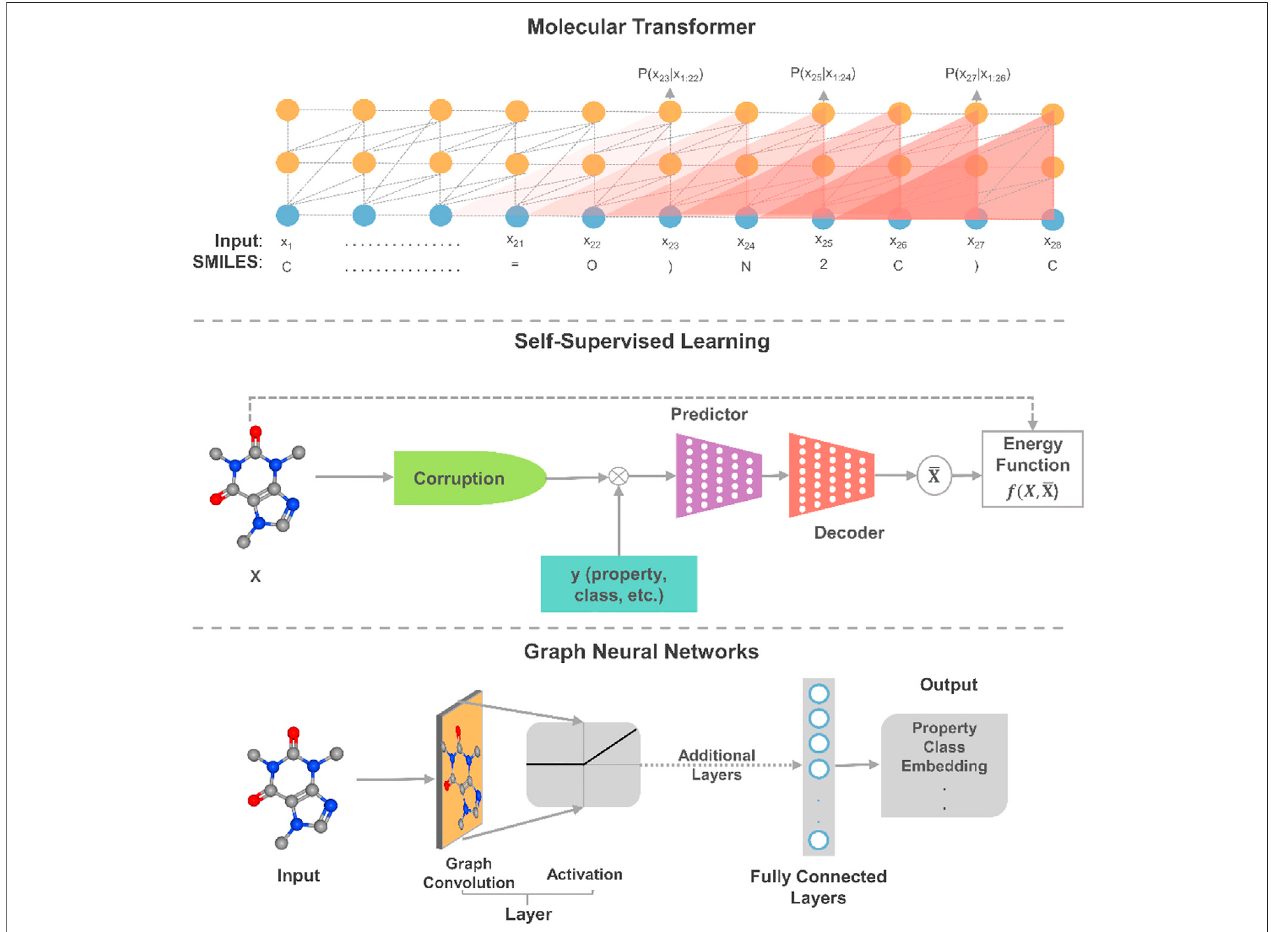
FIGURE 2 | An illustrative schematic of three promising applications of deep learning to molecular design. In self-supervised learning, this is a masked property- structure model, which is an instance of contrastive self-supervised learning. In the model, parts of some molecules are masked and properties are used to reconstruct the molecule from its masked/corrupted